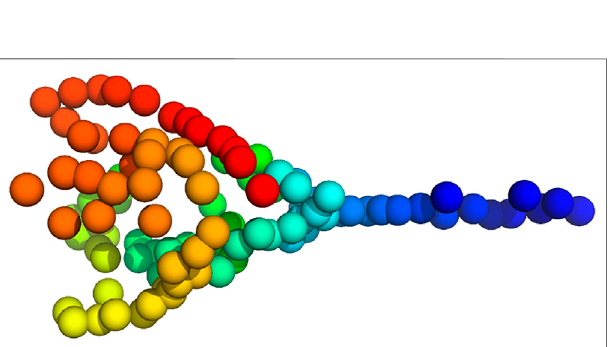
FIGURE 10 | Stochastic microscopy images of a plankton species. Top row: six (out of 16) projection images. Middle row: 2D point clouds representing the image data. Bottom row: 2D projections of the particle model calculated with Bayesian random tomography.